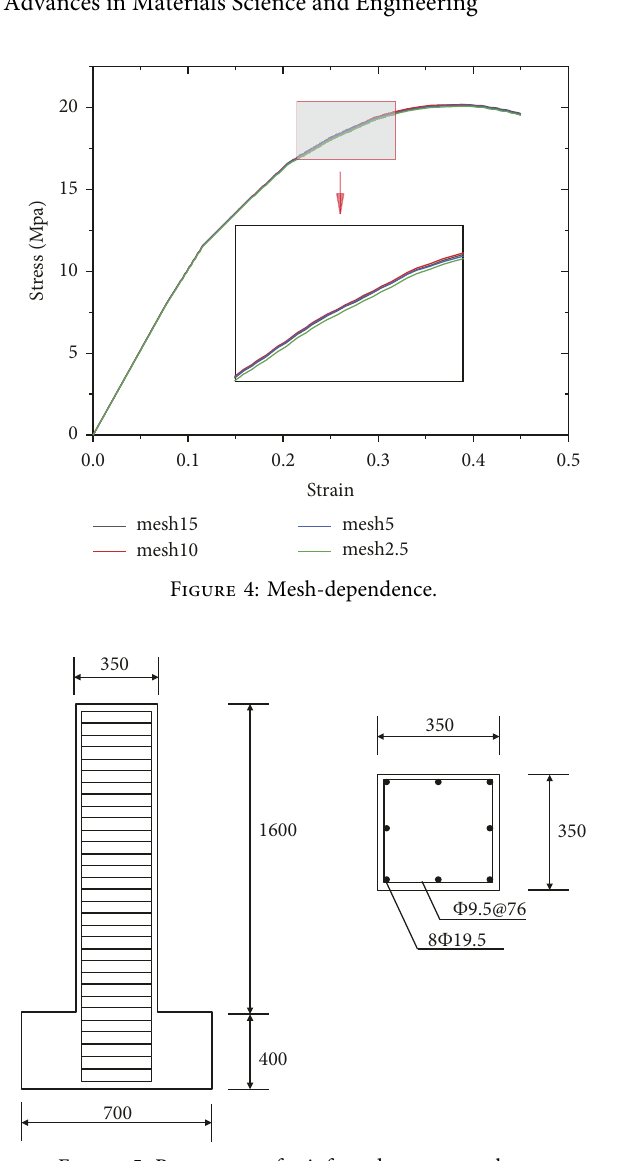
Figure 5: Parameters of reinforced concrete column.